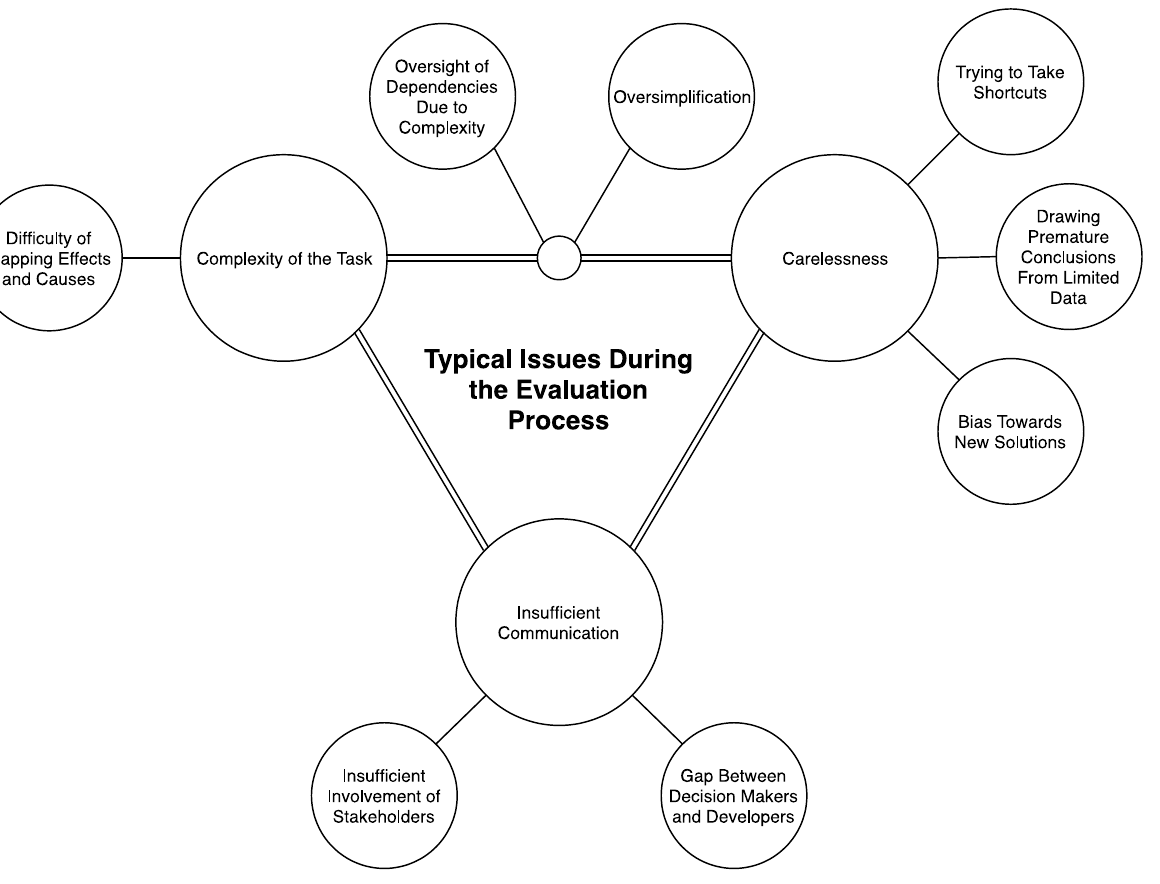
Figure 8. A list of typical issues during the evaluation